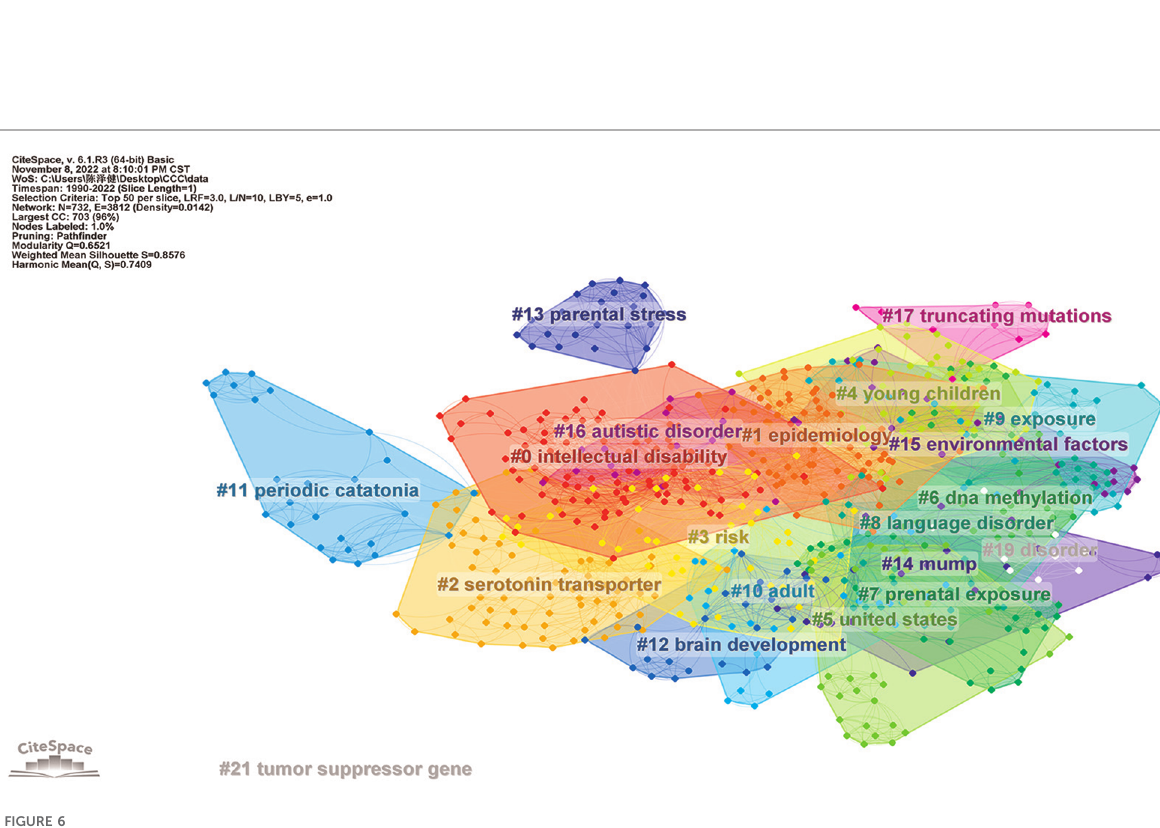
FIGURE 6 The cluster map of co-occurrence keywords related to risk factors on ASD since